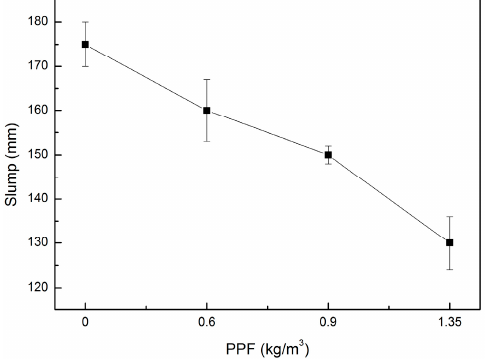
Figure 8. Effect of PPF on the slump of fresh concrete.